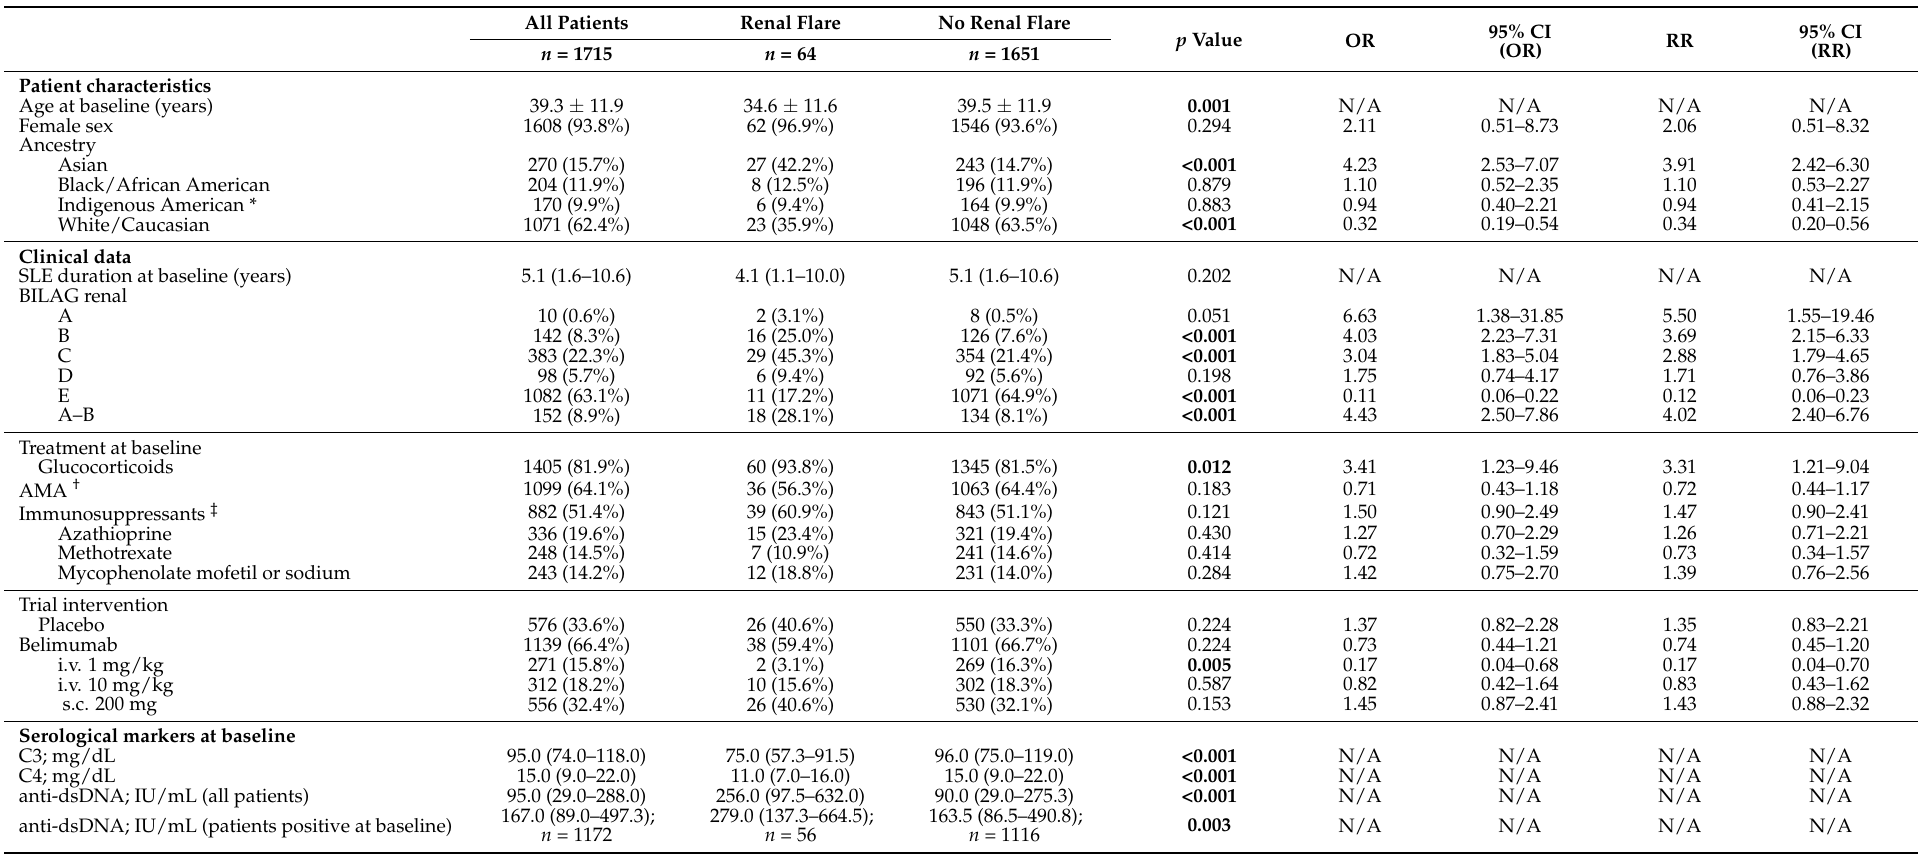
Table 1. Characteristics of patients who developed renal flares vs. patients who did not from baseline through week 52 in the pooled BLISS study population. All Patients Renal Flare No Renal Flare p Value